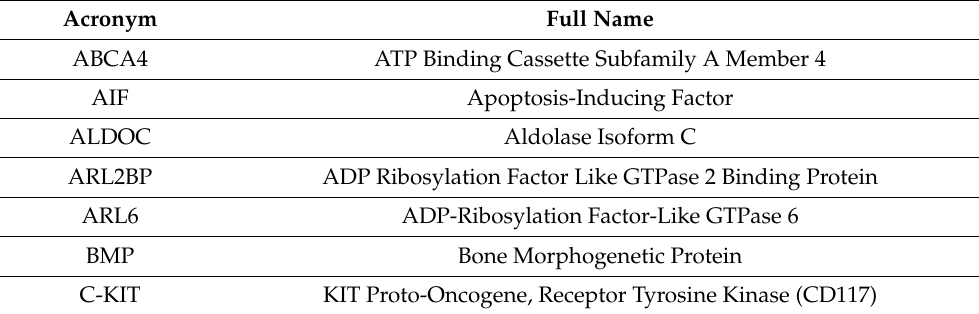
Table 2. Genes involved in photoreceptors development and